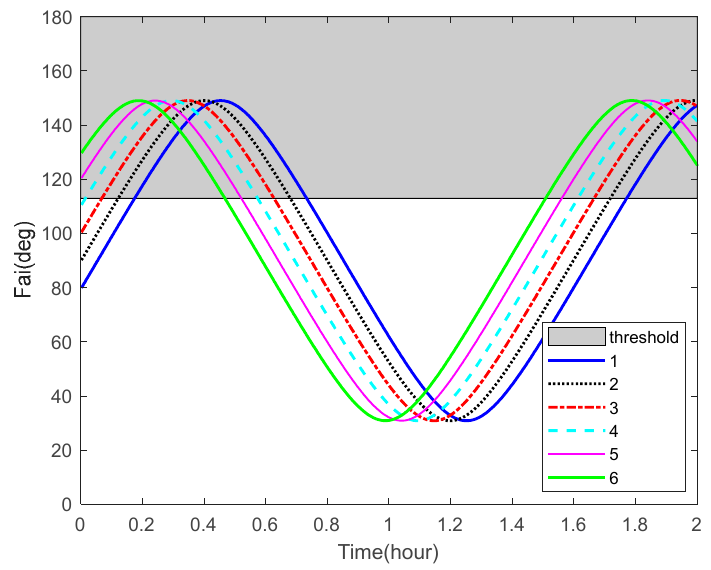
Figure 8. Apparent magnitudes of the space targets. The curves of the Sun-Earth-target angles of some space targets over time are shown in Figure 9. The angle bound 90 ◦ + β ( i ) , representing Earth’s shadow, is plotted as the shadow in the figure. From this result, we can see that the space targets are not in Earth’s shadow for most of the time.